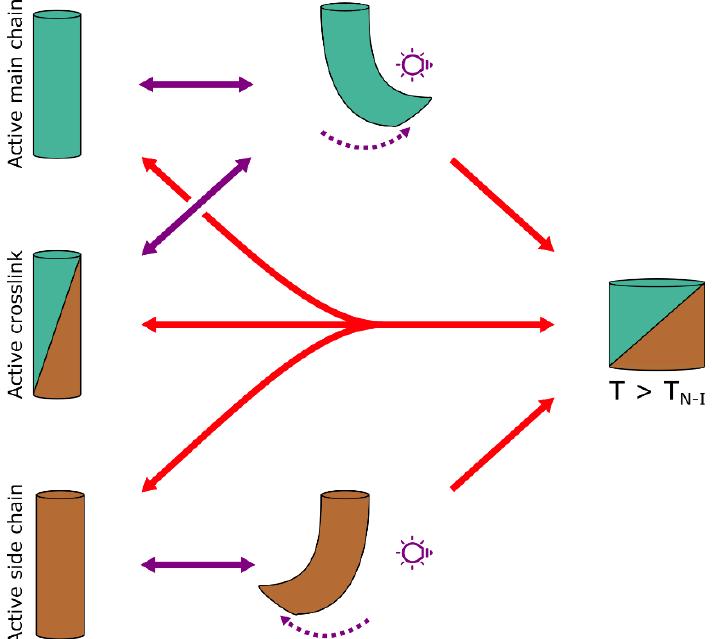
Figure 4. Schematic illustration of the different actuation modes of drawn LCE fibres. Fibres doped with a photomechanical chromophore in the main chain, or the crosslink will bend towards a (usually) UV-light source and return to their straight position with visible light illumination from any direction. Fibres that bear an azobenzene derivative pendant to the backbone bend away from a light stimulus. Additionally, heating the bent fibre can cause it to regain its straight shape though thermal relaxation of the chromophores. When the fibre temperature is appreciably high (above the nematic to isotropic transition temperature of the elastomer), the fibre will show a strong and reversible contraction along the fibre long axis.